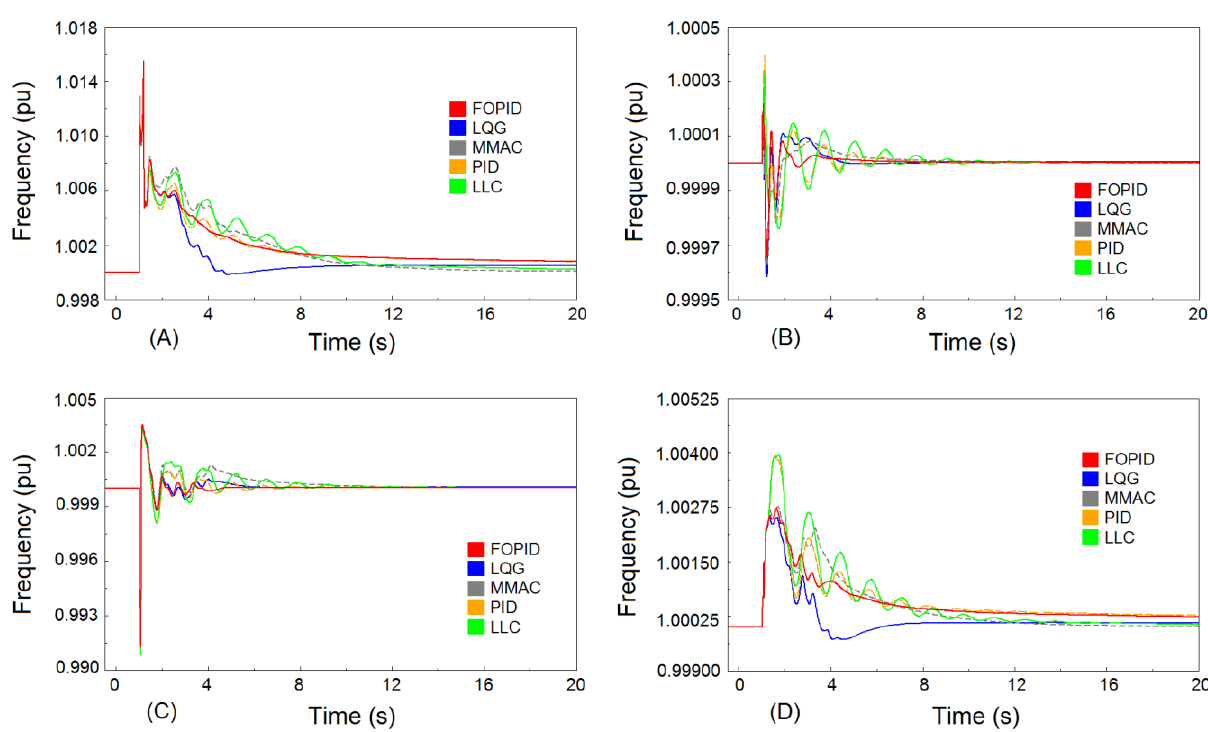
Figure 17. Rotor angle of generator G1 for scenario 3: ( A ) state 1, ( B ) state 2, ( C ) state 3, and ( D ) state 4.